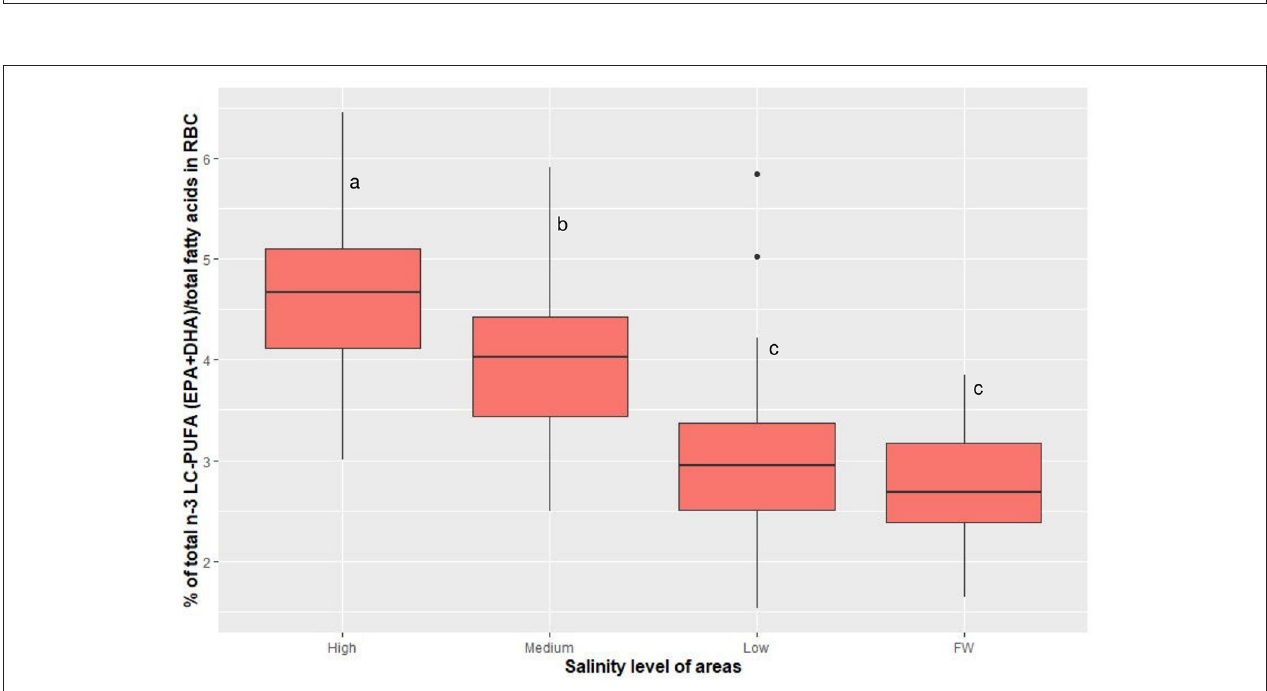
FIGURE 3 | Total n-3 LC-PUFA (EPA + DHA) as a percentage of total fatty acids (w/w) in RBC of adolescent females (10–19 years) across aquatic farming systems located across a saline gradient in SW Bangladesh [for in-depth household level study 60 households from each site with equal number from each social well-being group were considered, however for bloodspot collection we took 50 households from each site; different lettering above each whisker indicate significant differences ( P < 0.05)].